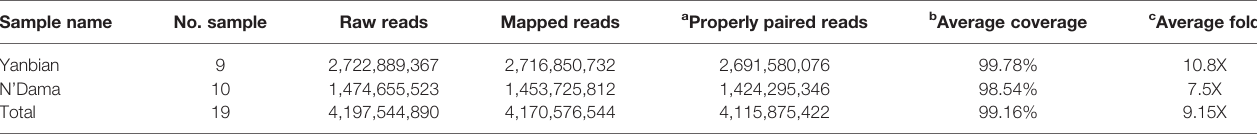
TABLE 1 | Summary statistics of Yanbian and N ’ Dama cattle re-sequenced